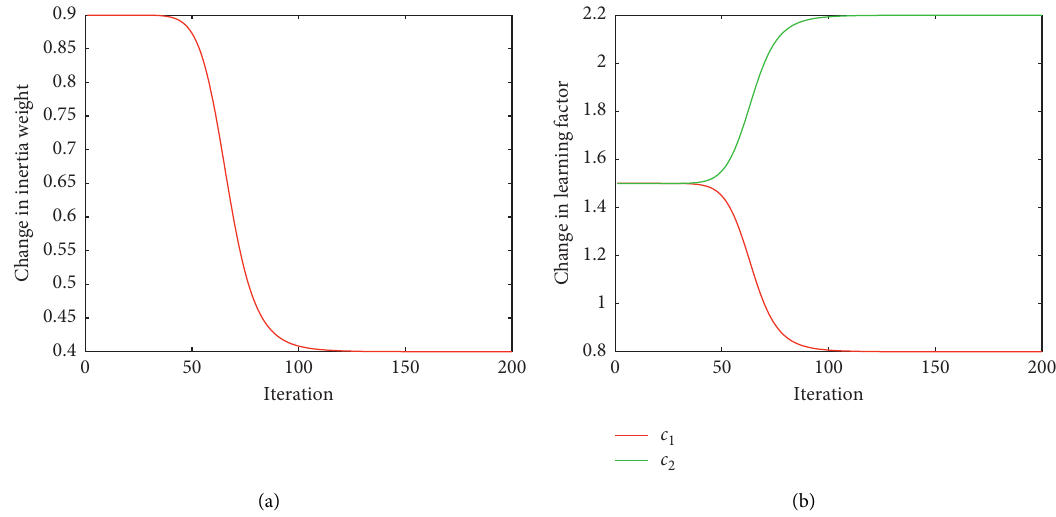
Figure 1: The curves of (a) new inertia weight and (b) learning